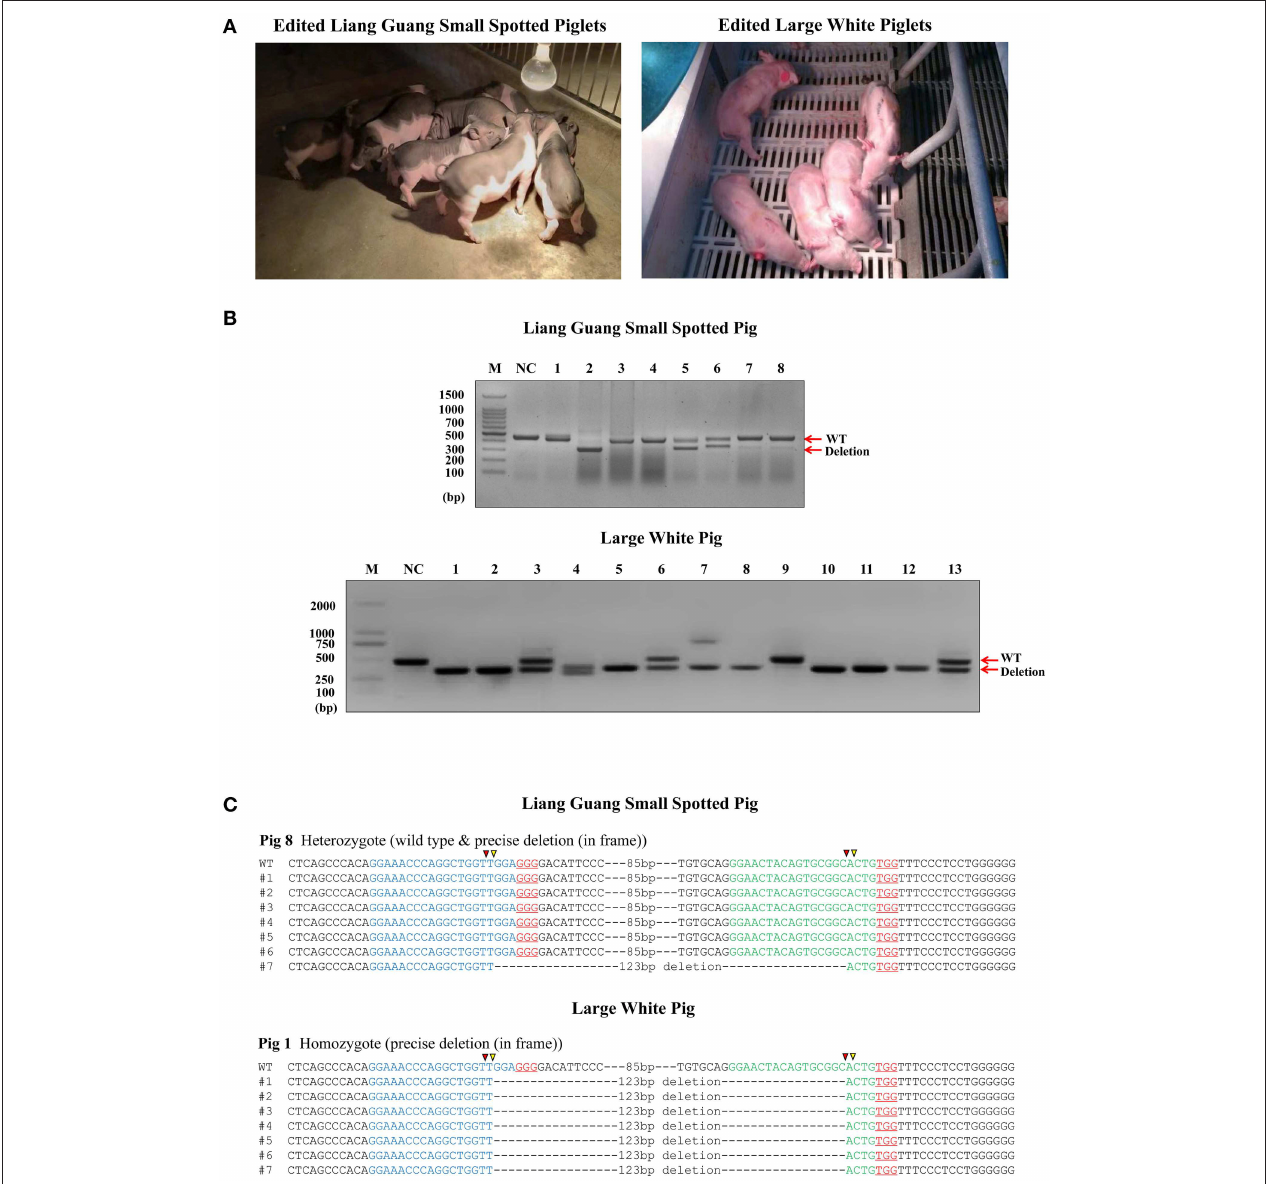
FIGURE 2 | Generation of pigs harboring a precise partial deletion of CD163 SRCR5. (A) Representative photos of CD163-edited Liang Guang Small Spotted piglets and Large White piglets. (B) Genotyping of edited piglets. DNA was extracted from ear biopsies and genotype was assessed by PCR across the target sites of the paired sgRNAs. The PCR product of the unmodified genome is predicted to be 441 bp, while the deletion (123 bp) should result in a 317 bp PCR product. NC, negative control using the PCR product from wild-type genomic DNA. Each numbered lane indicates the PCR product from one healthy gene-edited piglet. (C) Sequencing of the cloned PCR products shows a representative Liang Guang Small Spotted piglet carrying a heterologous in frame deletion (123 bp) in CD163 SRCR5, and a representative Large White piglet carrying a homologous in frame deletion (123 bp) in CD163 SRCR5. Red and yellow triangles are predicted cutting sites of Cas9